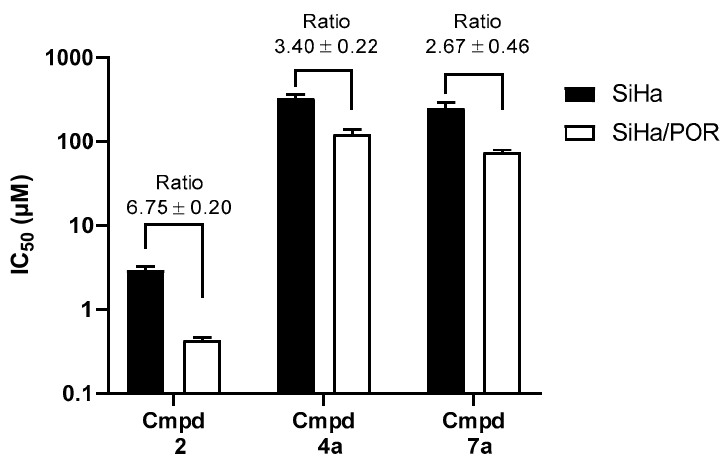
Figure 6. IC 50 values for inhibition of proliferation of SiHa and SiHa / POR cells by SN30000 ( 2 ) and BTO acids 4a and 7a . Drug exposure was for 4 h under anoxia, at pHe 7.4, with regrowth under aerobic conditions for 5 days before staining with SRB. Values are means and SEM for the two experiments, each with triplicate cultures at each drug concentration.